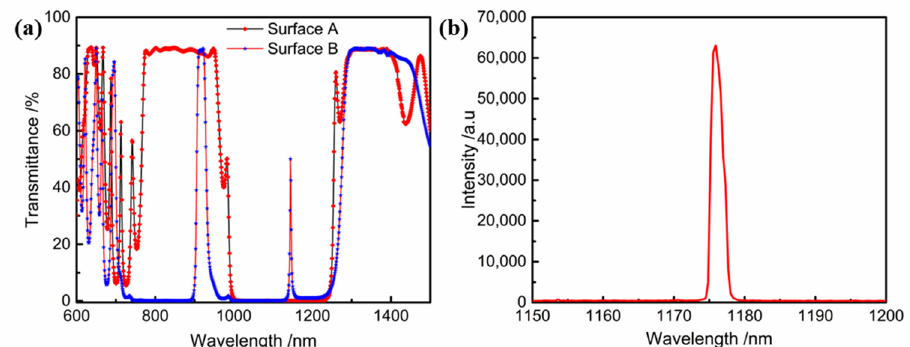
Figure 10. ( a ) Measured transmittance spectral curve of Nd:YVO 4 crystal with single-sided coating. ( b ) 1176 nm laser output pattern obtained under 808 nm laser excitation.